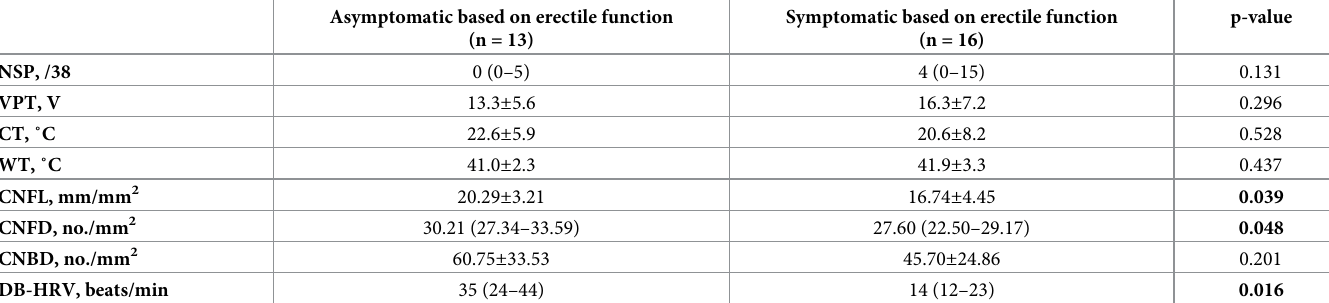
Table 2. Comparison of measures of neuropathy between asymptomatic and symptomatic patients divided based on erectile function. Asymptomatic based on erectile function (n = 13)